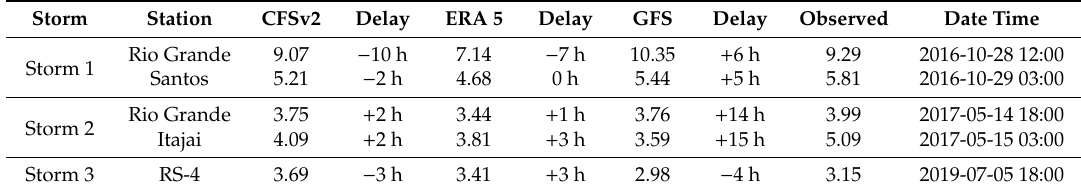
Figure 11. Scatter plot of maximum Hs. Table 3. Maximum Significant Wave Height and timing (values in